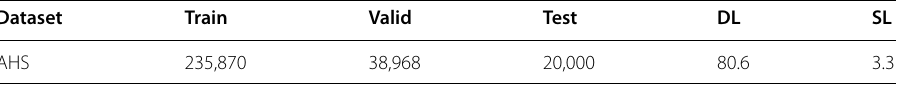
DL and SL denote average number of tokens in source document and summary, respectively